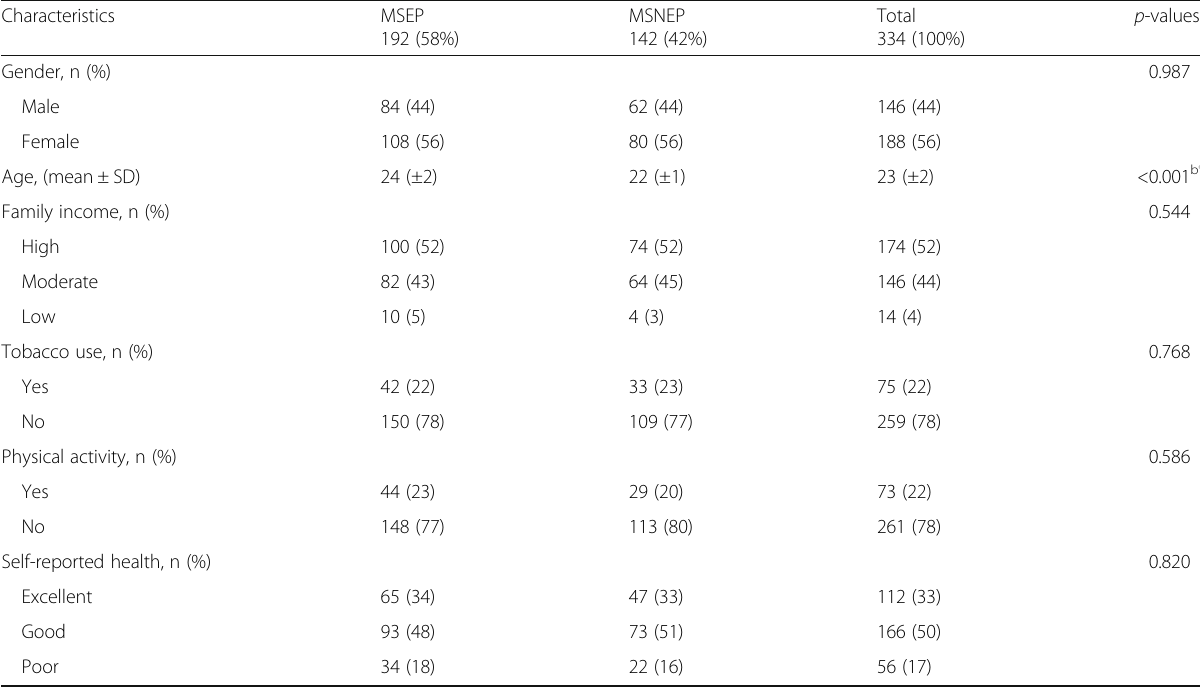
Table 1 General characteristics of the medical students included in the